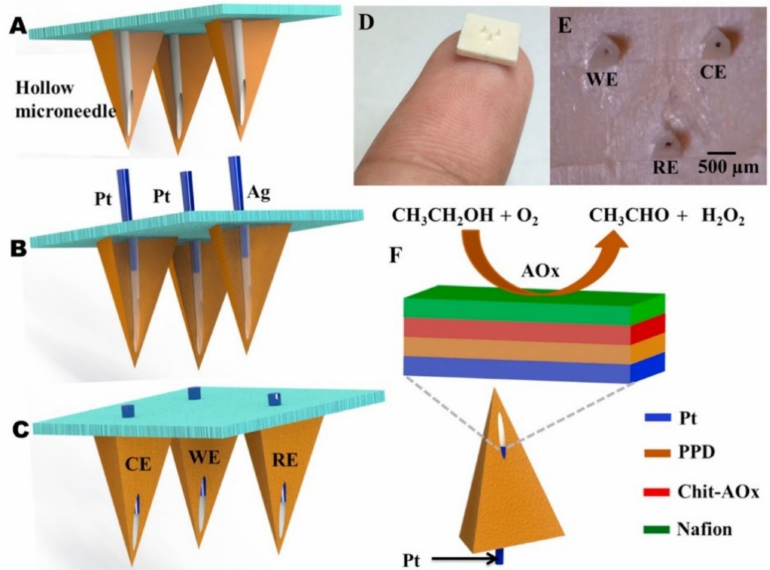
Figure 8. ( A – C ) MN array with integrated Pt (WE, CE) and Ag (RE) wires press-fitted into the aperture of hollow MN. ( D ) MN array mounted on the fingertip. ( E ) Optical micrograph of the MN array ( F ) Schematic representation of multilayer alcohol biosensor and alcohol-sensing mechanism. Reproduced with permission from Reference